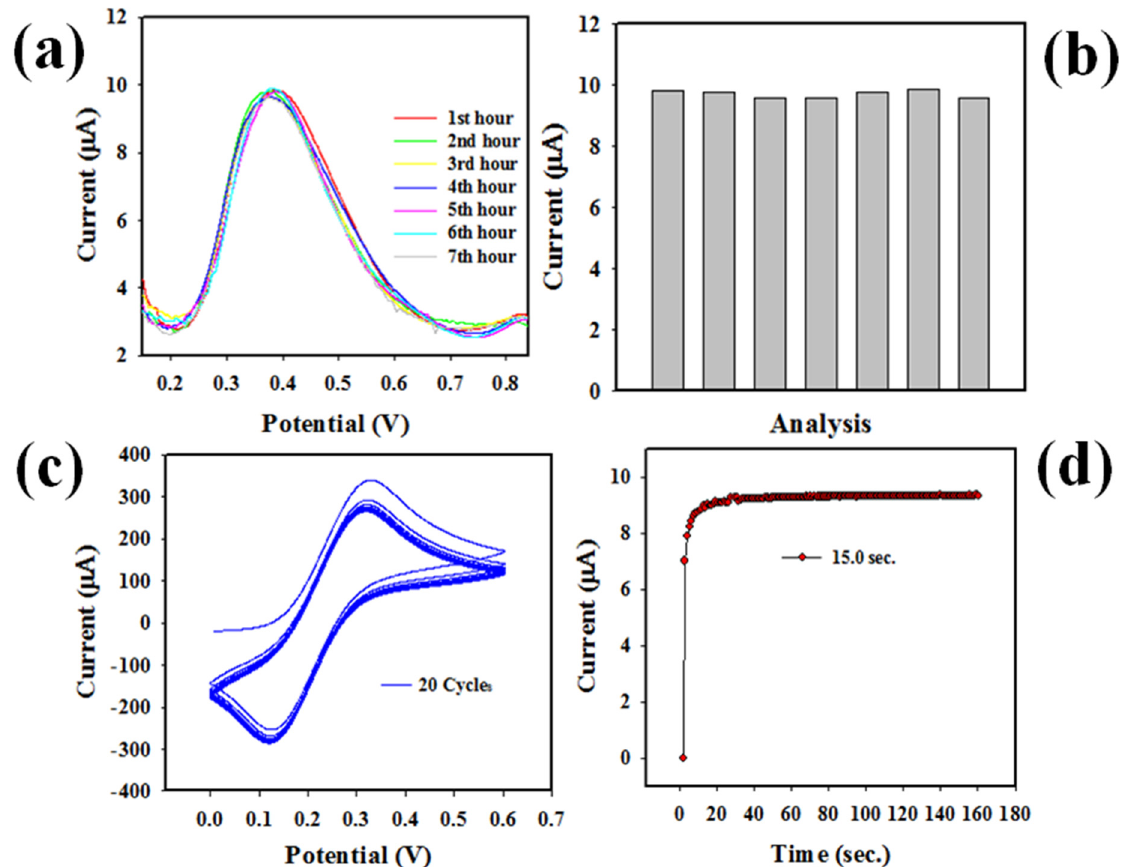
Figure 10. Optimization of sensor. ( a ) UA sensor reproducibility test, ( b ) reproducibility bar diagram of UA sensor, ( c ) performing stability test, and ( d ) response time of UA sensor.